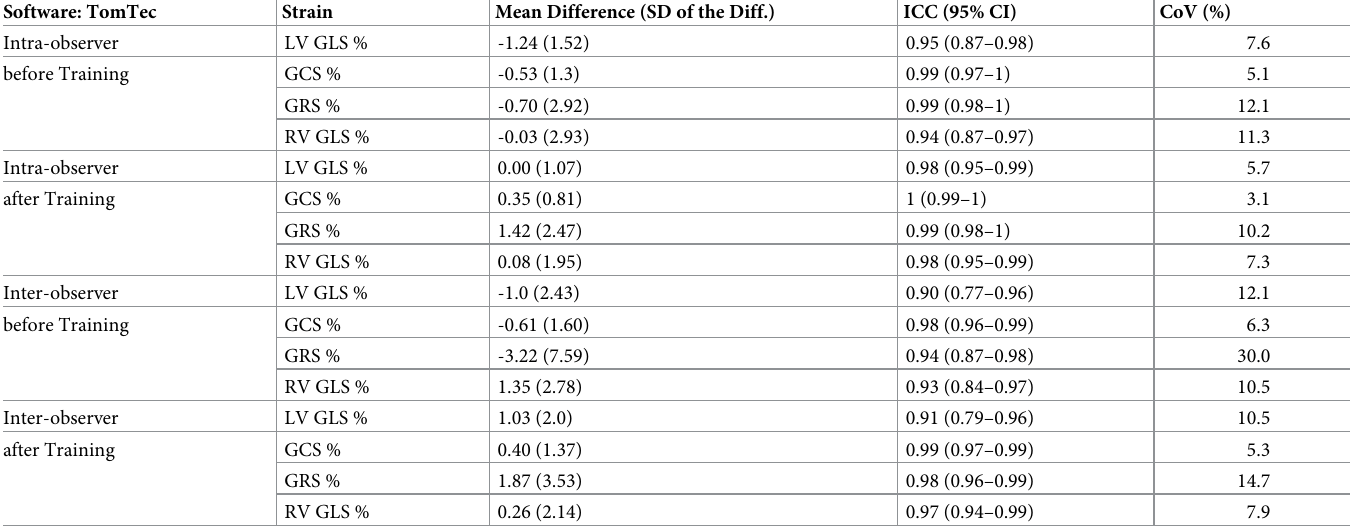
Table 4. Intra- and inter-observer reproducibility using TomTec prior to and after training. Software: